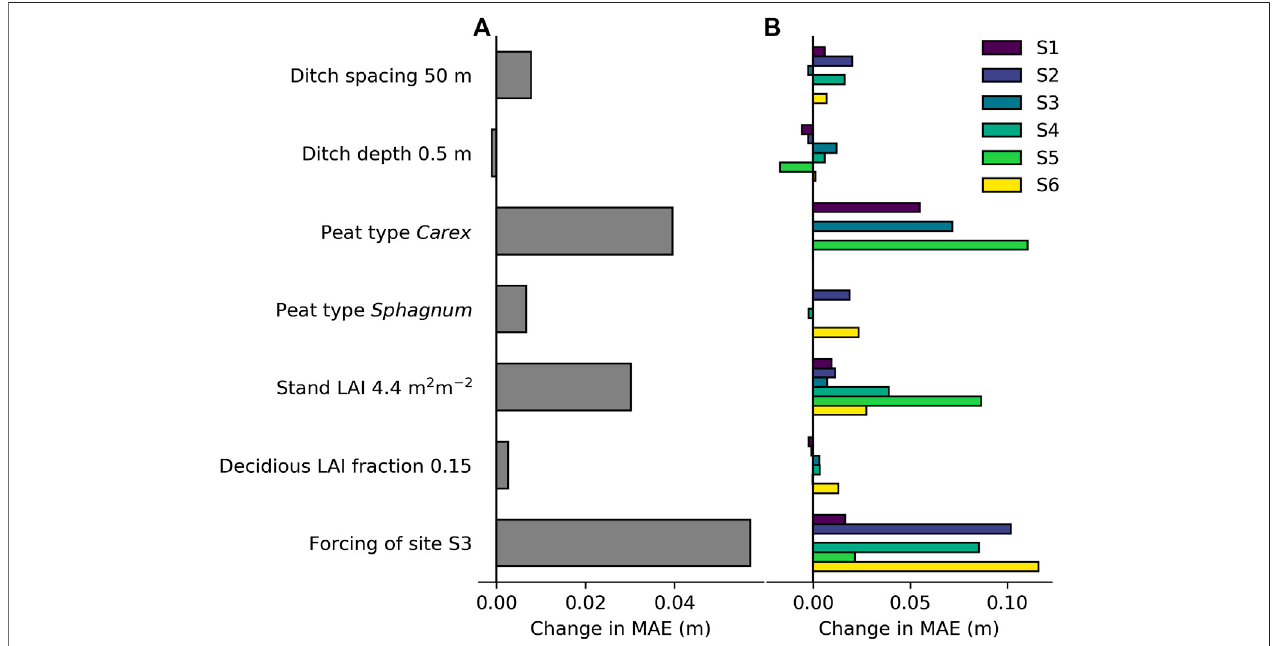
FIGURE7| Effectofstandardizingmodelparametersandmodelforcingonebyoneonmodelperformanceinpredictedwatertablelevel: (A) Effectonsiteaverage mean absolute error (MAE; see Eq. 10 ) and (B) effect on MAE of sites individually. A positive change in MAE indicates impaired model performance compared to model simulations where none of the factors are standardized.